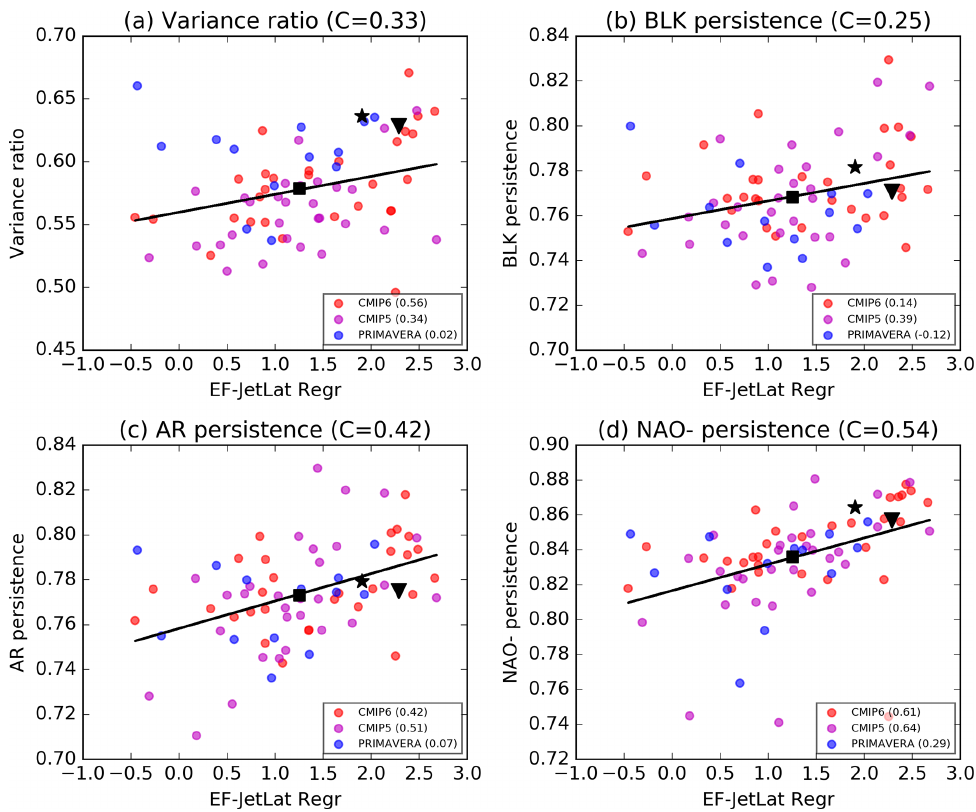
Figure 15. The covariation between eddy feedback strength and variance ratio (a) and regime persistence (b–d) in CMIP5, CMIP6, and HighResMIP datasets. Dots mark the value for each climate model, while a square indicates the multi-model mean value. A star and triangle mark the values estimated from the ERA5 and ERA20C reanalyses respectively. For models with multiple ensemble members, the ensemble mean values have been used. Trend lines show the best fit linear relationship for all models, with the Spearman correlation indicated as the value C in each subplot title. The correlation between variables for each individual model dataset is shown in the subplot